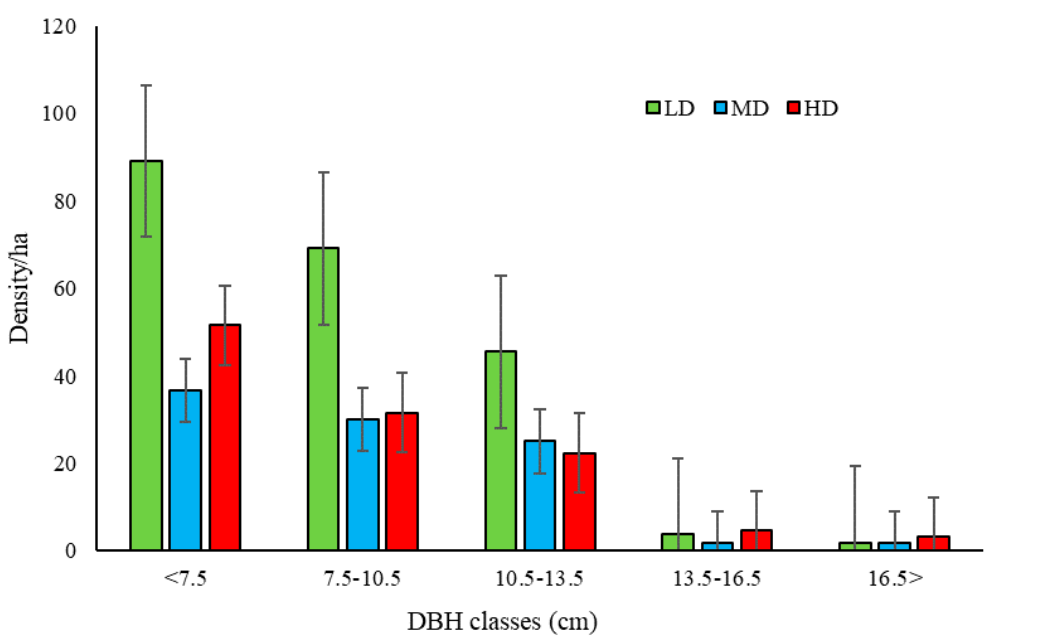
Figure 2. Tree (DBH ≥ 5 cm and height ≥ 1.5 m) density by diameter at breast height (DBH) class and destruction class in a naturally-regenerated broadleaf forest in the Arasbaran biosphere reserve in Iran ( n = 30). LD = Low Destruction, MD = Medium Destruction, and HD = High Destruction. See Table 2 for a description of the destruction class.